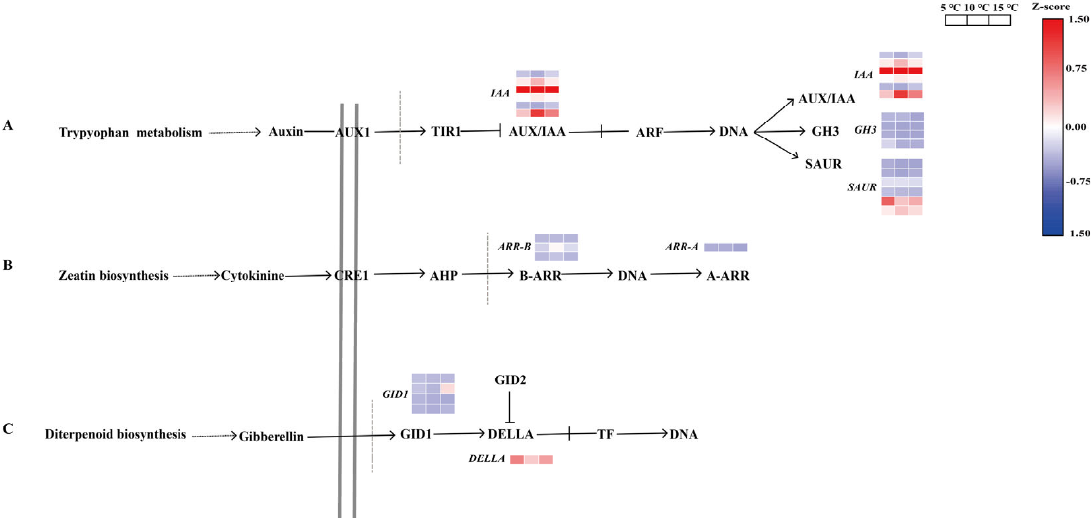
Figure 6. The expression patterns of genes in the plant hormone signal transduction under different DIF treatments. DIF